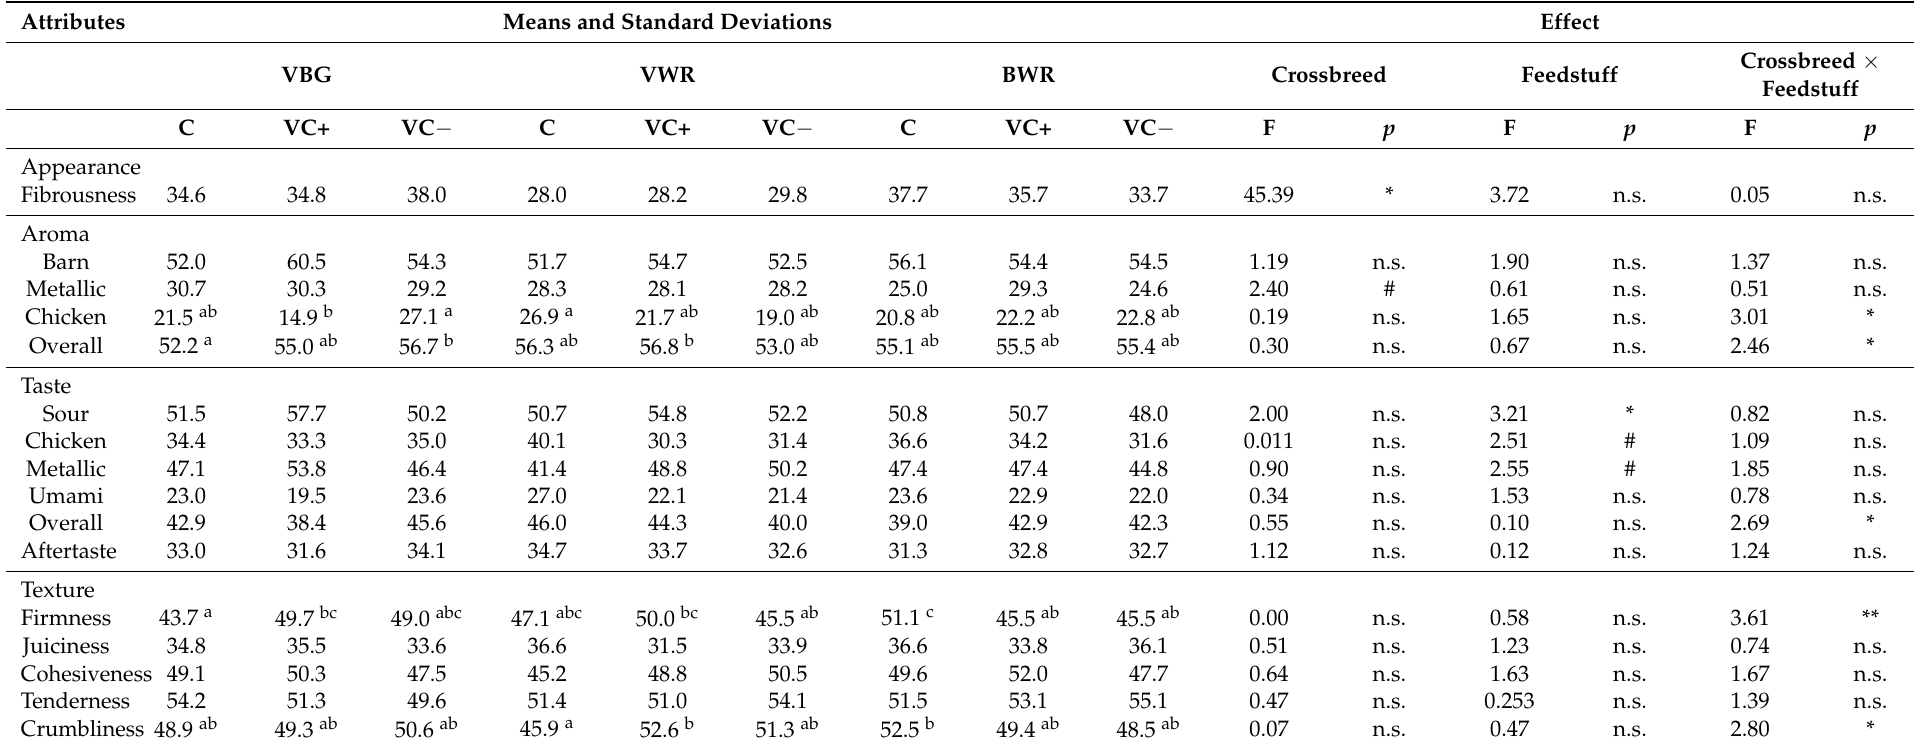
Table 5. Means, standard deviations and crossbreed, feedstuff and interaction effect for sensory